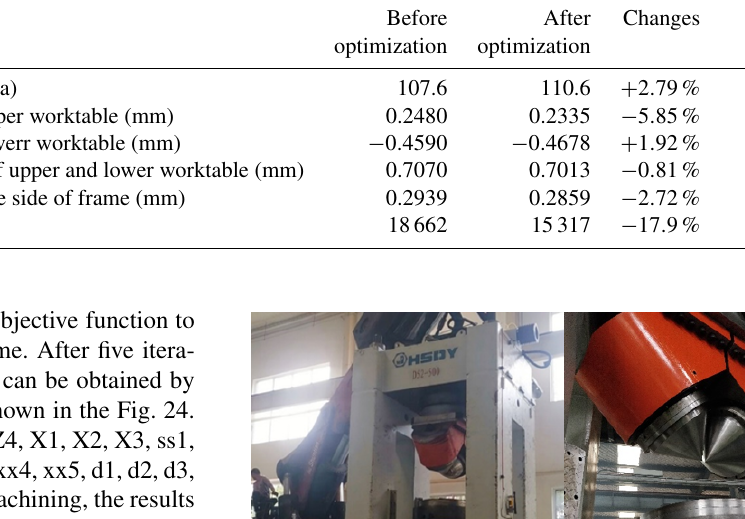
Figure 24. Size comparison before and after optimization. Table 2. Performance comparison of double roll rotary forging machine frame before and after size optimization. Frame performance parameters